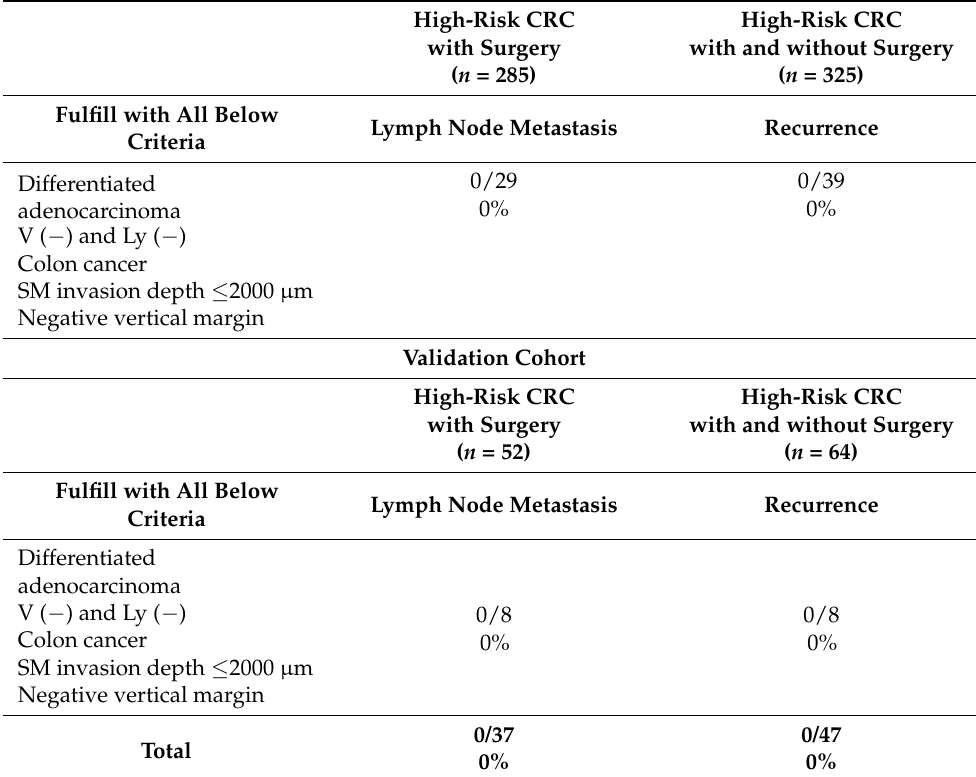
Table 6. New proposal that can skip completion surgery for the high-risk pT1